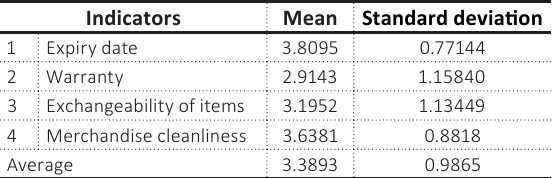
Table 5. Mean score for service